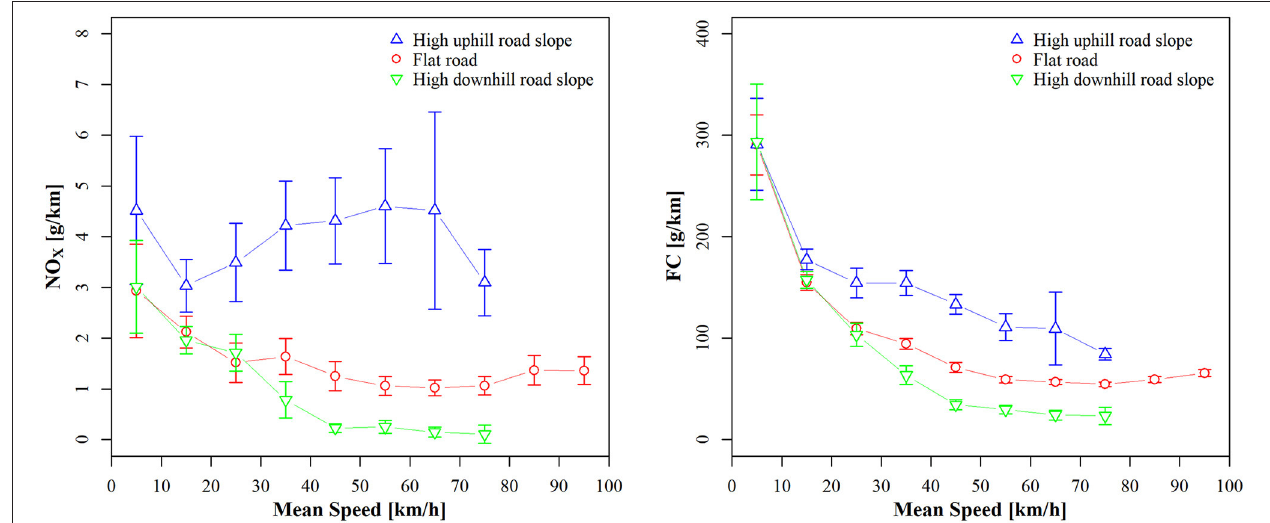
FIGURE 9 | NO x (left) and FC (right) levels over speed for high uphill road slope (slope > 5%), for flat road ( | slope | < 0.5%) and for high downhill road slope (slope < − 5%), for the pre-Euro 4N case study (distance-integration: 500m). Error-bars indicate the 95% confidence interval of the mean levels.